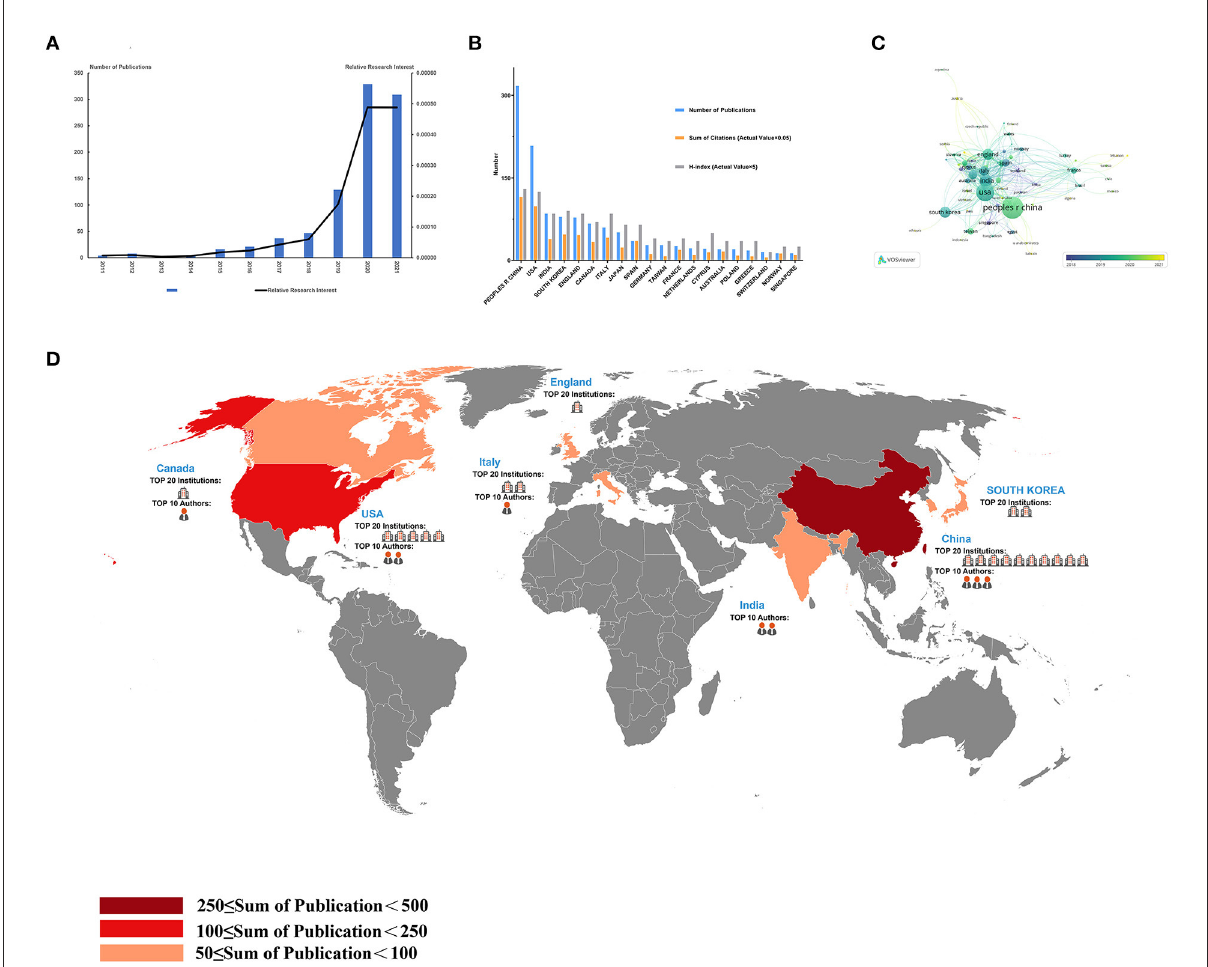
FIGURE3 Contributions of different countries/regions to the application of artificial intelligence in the field of ultrasound, and a global cooperation network in this field. (A) The world publication of RRI in the time course of artificial intelligence applications in the field of ultrasound; (B) Total publications, total citations and H-index of the 20 most productive countries/regions; (C) A network of cooperative relations between States; (D) country contributions, institutions and the distribution of the Top 10